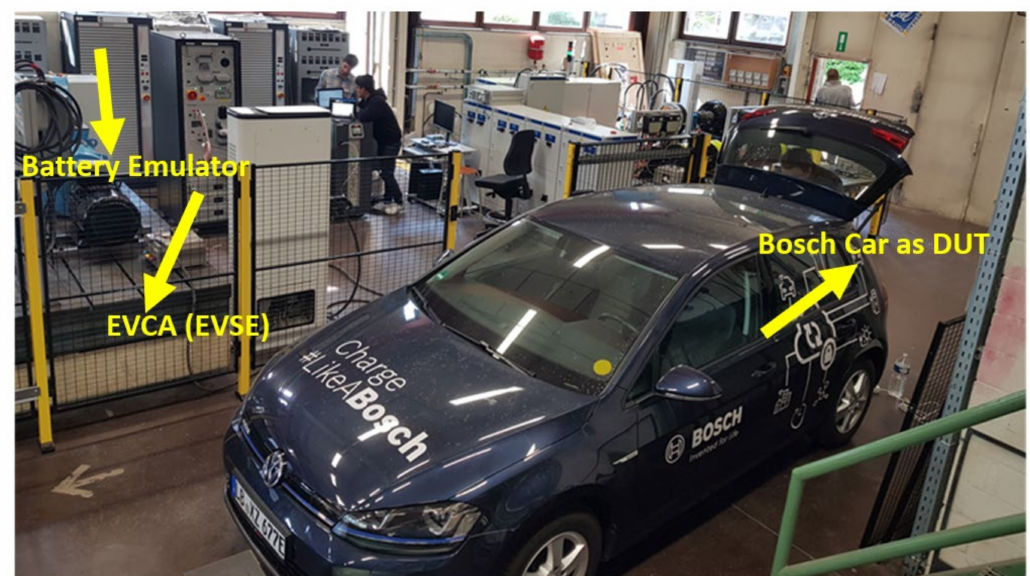
Figure 9. Experimental setup for V2G test with BOSCH passenger car.